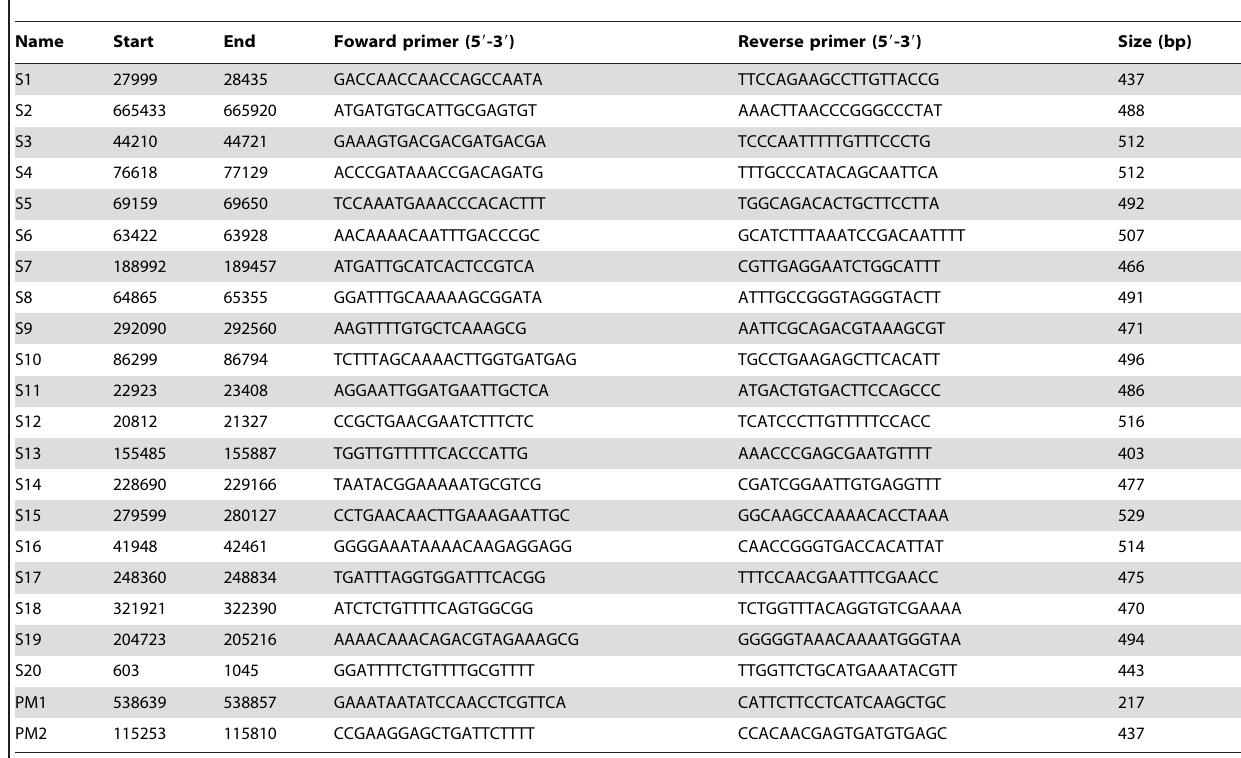
Table 1. The name, position on supercontig, size, and primers used for amplification of 22 intergenic